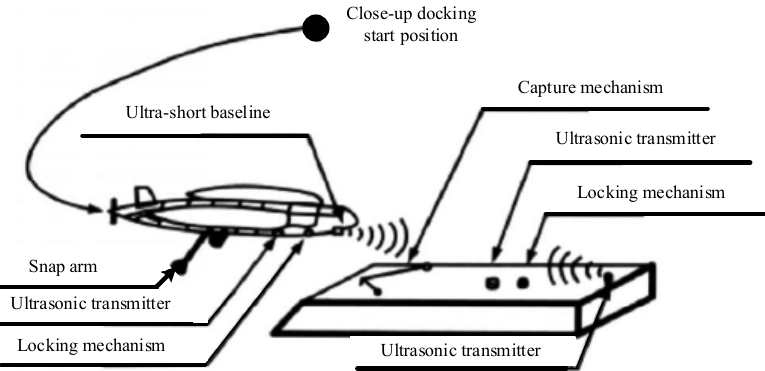
Figure 7. Marine-bird underwater docking platform.